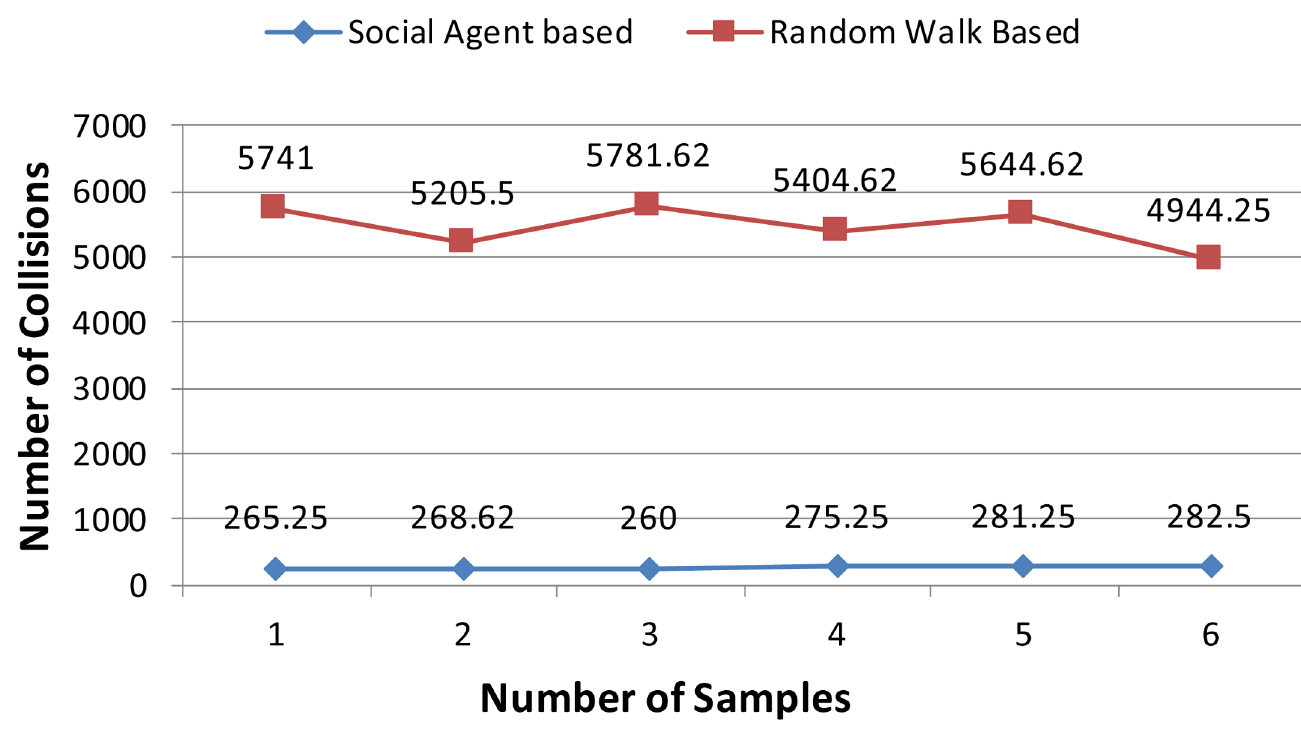
Fig 6. Graphical representation of test case